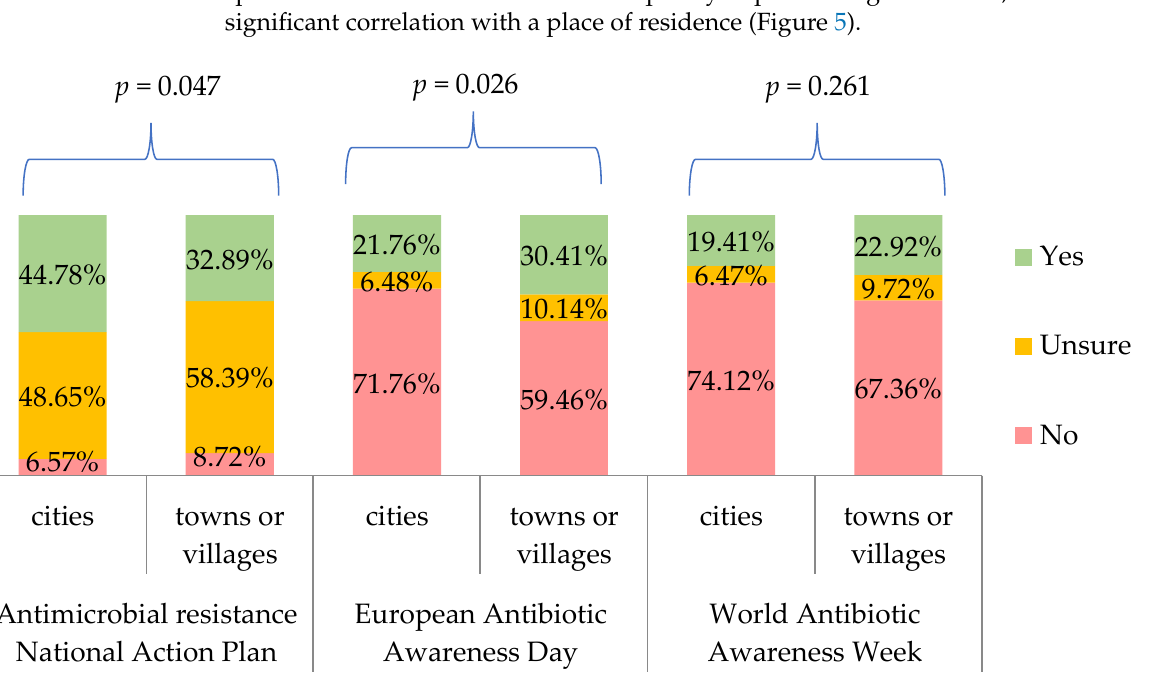
Table 8. Respondents who believe European Antibiotic Awareness Day and World Antibiotic Awareness Week have been effective/ineffective in raising awareness about prudent use of antibi- otics and antibiotic resistance in their country ( n = 504).